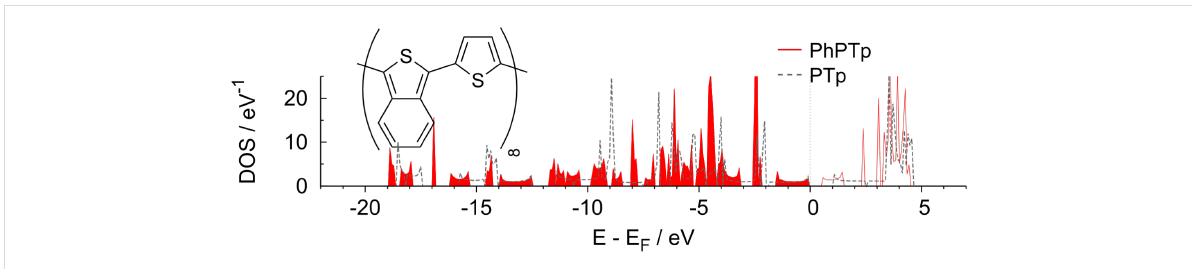
Figure 8: Calculated DOS of PhPTp compared to PTp. The inset illustrates the structure of PhPTp.